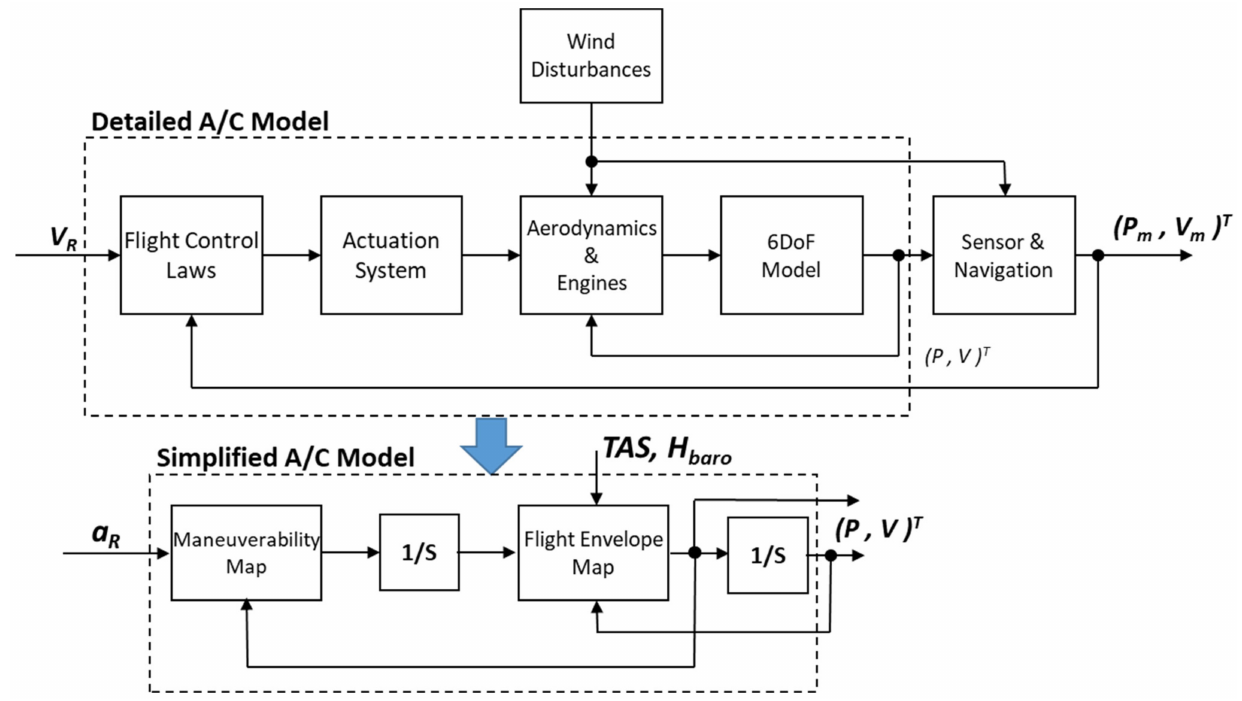
Figure 4. Simplified own aircraft model for CDA